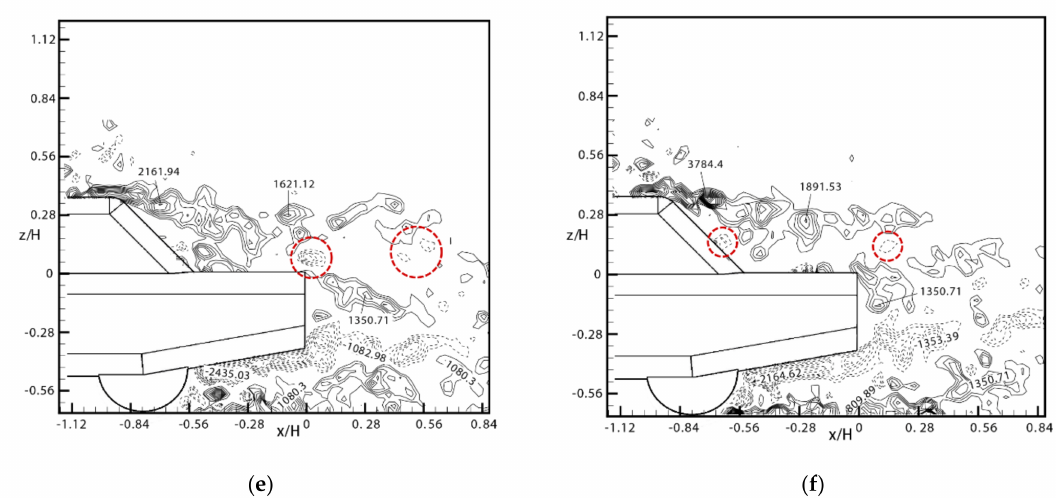
Figure 20. The hairpin vortex shedding sequence at y/H = 0. Minimum and incremental values of vorticity are − 542.159 s − 1 , 539.48 s − 1 , and ∆ ω y = 300.455 s − 1 , respectively. ( a – f ) shows the certain formation and shed- ω y,min = ding cycle of the hairpin vortex.